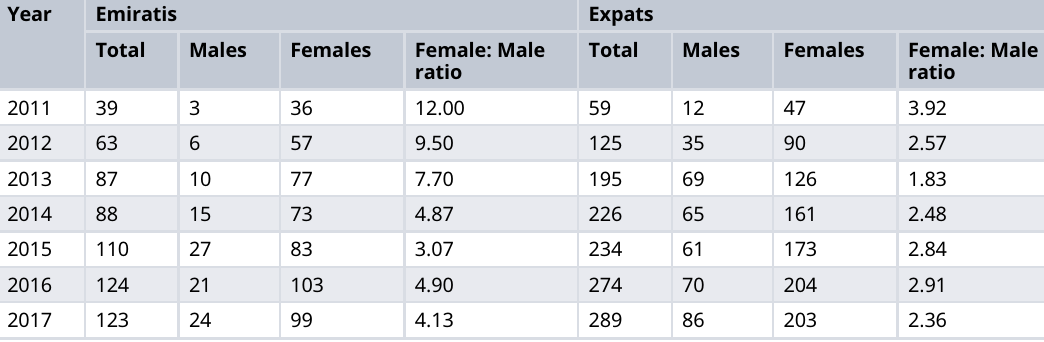
Table 6. UAE gender distribution of thyroid cancer incidence from 2011 to 2017.